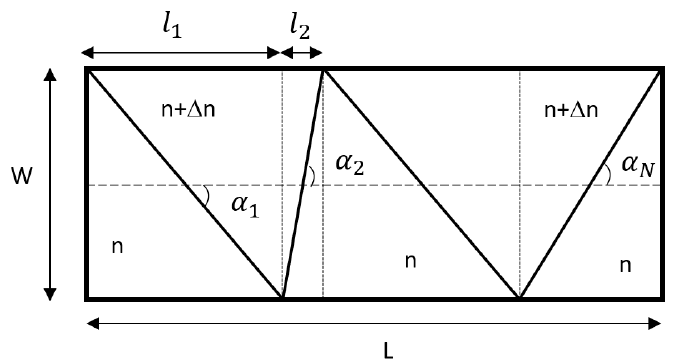
Figure 12. The arbitrary electrodes on the rectangular PMN-PT ceramic (top view).